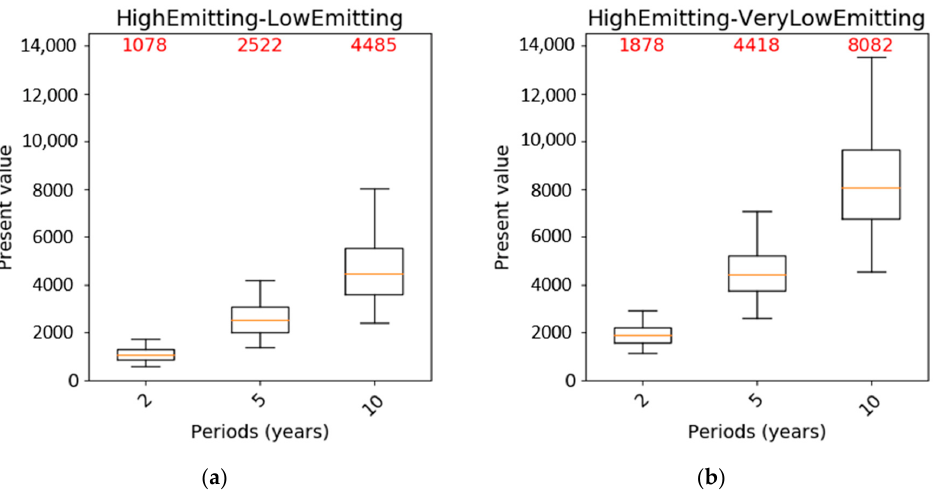
Figure 7. Present values calculated with different numbers of periods (in this case, years). ( a ) Scenario HE − LE. ( b ) Scenario HE − VLE. HE − LE. ( b ) Scenario HE −